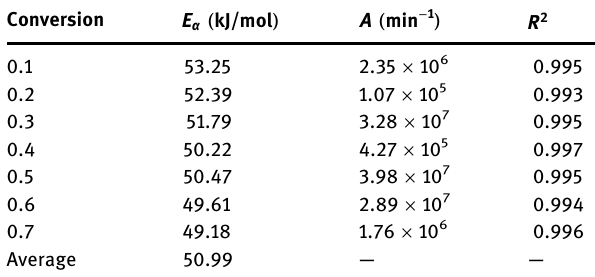
Table 6: Combustion kinetic parameters of sample K3 Conversion